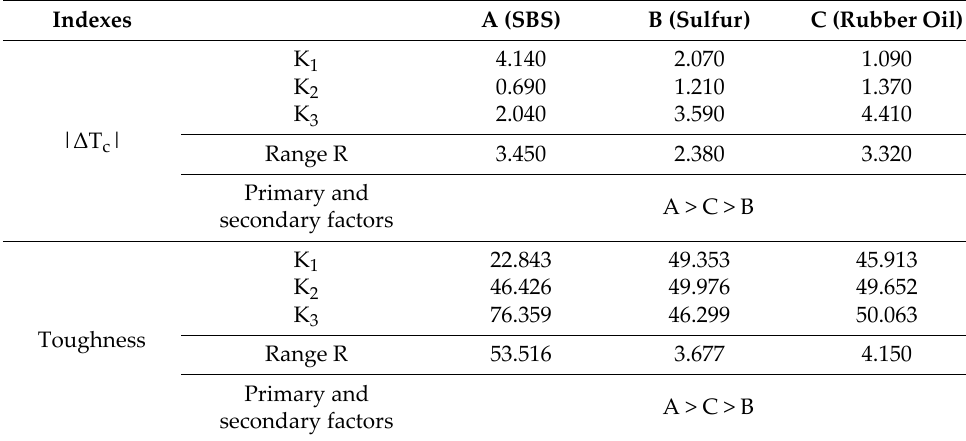
Table 7. Orthogonal test results. Indexes